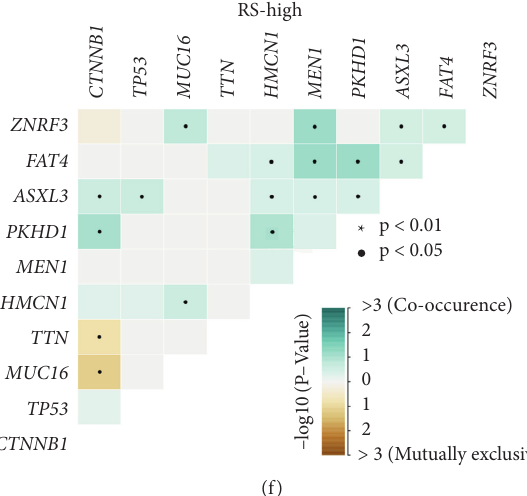
Figure 6: Mutational analysis in different risk groups: (a and b) oncoplots for ACC samples with low- and high-risk scores were generated, respectively; (c) with a threshold of p < 0.05 using Fisher’s exact test, a differentially mutated gene named CTNNB1 was detected between the two risk cohorts; (d) significant higher tumor mutation burden (TMB) was observed in ACC samples with higher risk scores; and (e and f) more co-occurrence mutations were observed in the low-RS cohort, and more mutually exclusive mutations were observed in the high-RS